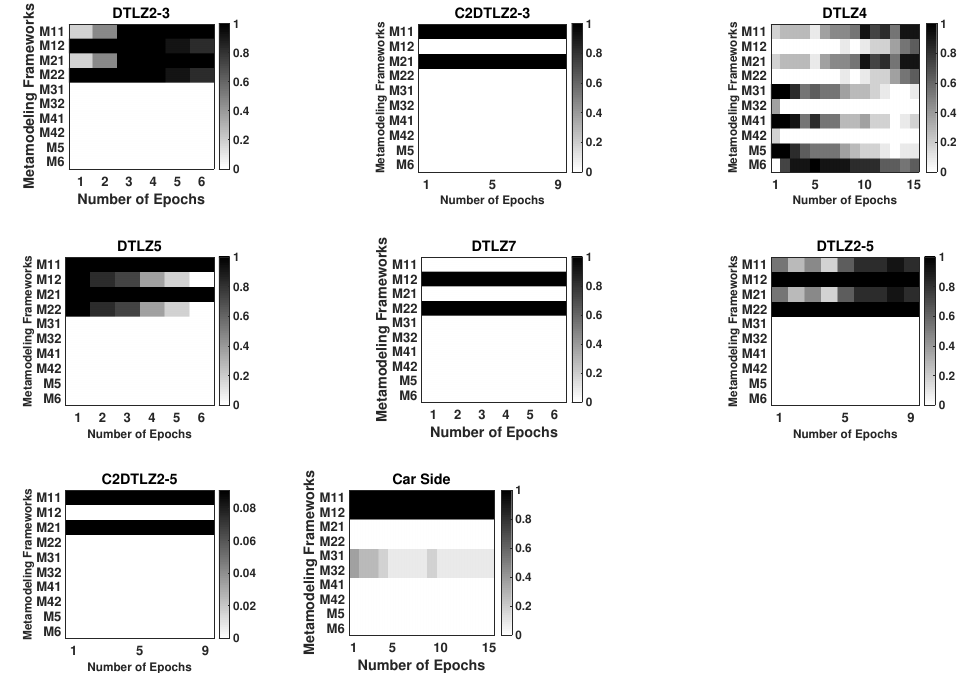
Figure 10. Epoch-wise proportion of usage of 10 frameworks in 11 runs of the ASM approach for three and five-objective